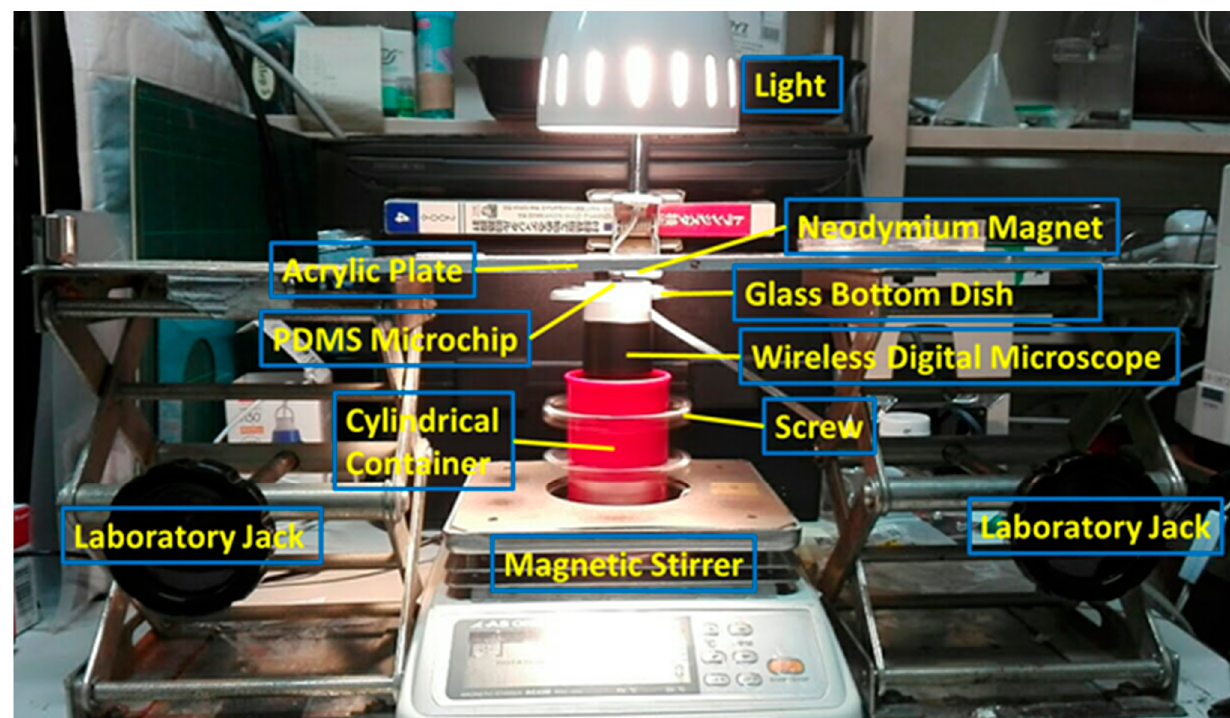
Figure 3. Photograph of the actual observation system for the MMSB.